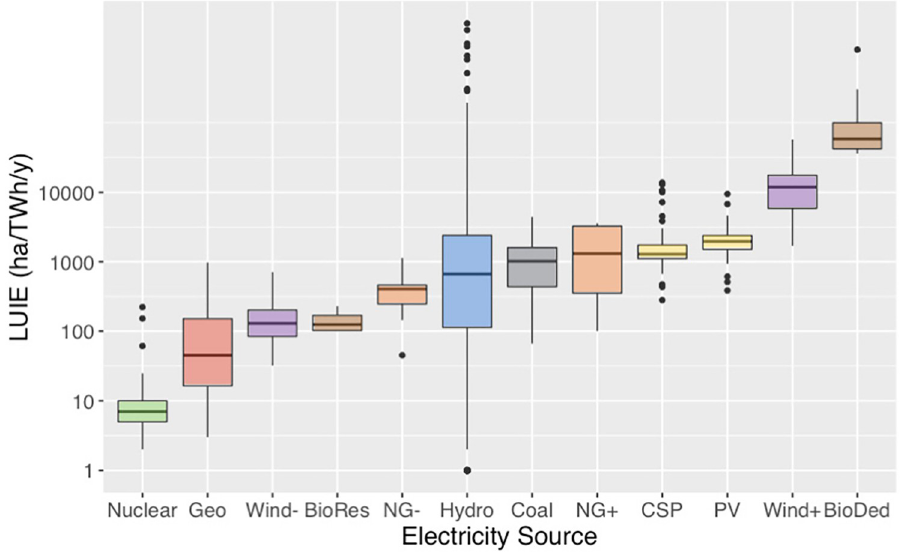
Fig 1. Land use intensity of electricity (LUIE: ha/TWh/y), shown on log scale. Boxes represent the inter-quartile range with the median as the middle bar. Whiskers extend to the highest or lowest data point that is within 1.5 times the inter-quartile range; points outside this range represent outliers. Electricity sources: nuclear energy (Nuclear), geothermal energy (Geo), wind energy with footprint only, (Wind-), natural gas footprint only (NG-) and including spacing (NG+), hydroelectric power for single purpose dams (Hydro), coal (Coal), concentrating solar power (CSP), ground-mounted photovoltaic solar energy (PV), wind energy with footprint (Wind-) and spacing (Wind+), and residual biomass (BioRes) and dedicated biomass